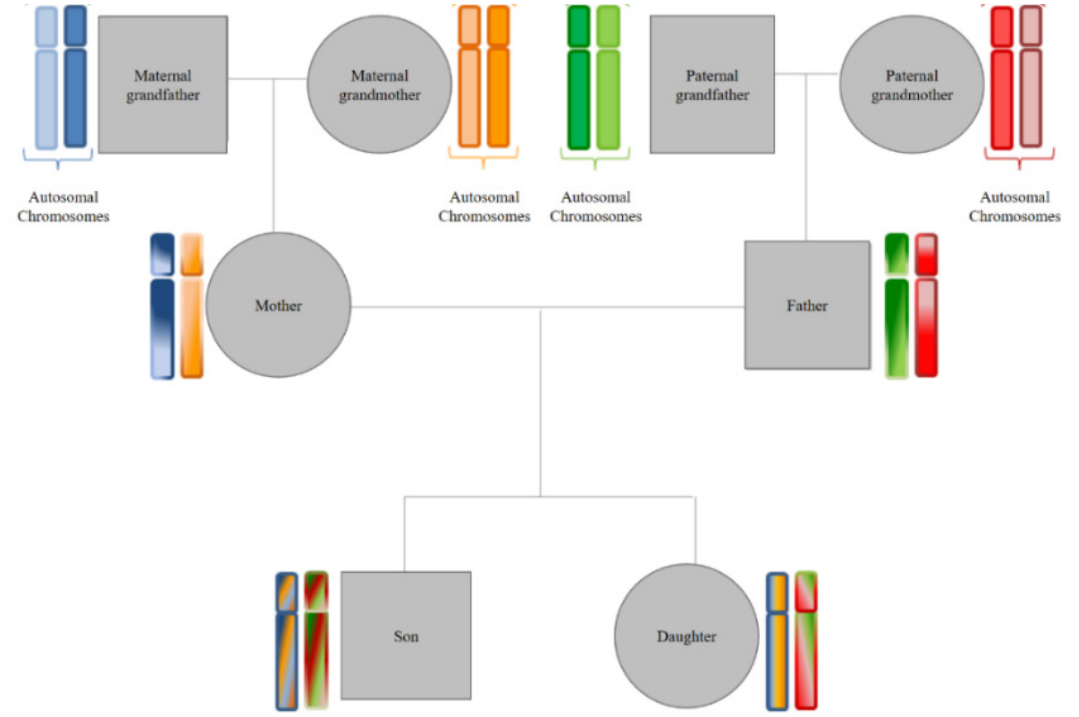
Figure 1. Autosomal chromosome transmission from the maternal and paternal sides. The recombination of the genetic information can be visualized by the mixed colours in the progeny’s chromosomes. Source: (Gomes 2020).